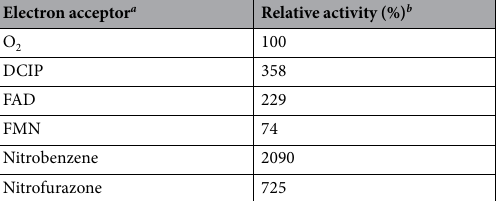
Table 2. Identification of electron acceptors of B. infantis NPOX. a Relative activity (%) was calculated in comparison with the activity of NADPH oxidase. Data are the average of two independent measurements that varied by less than